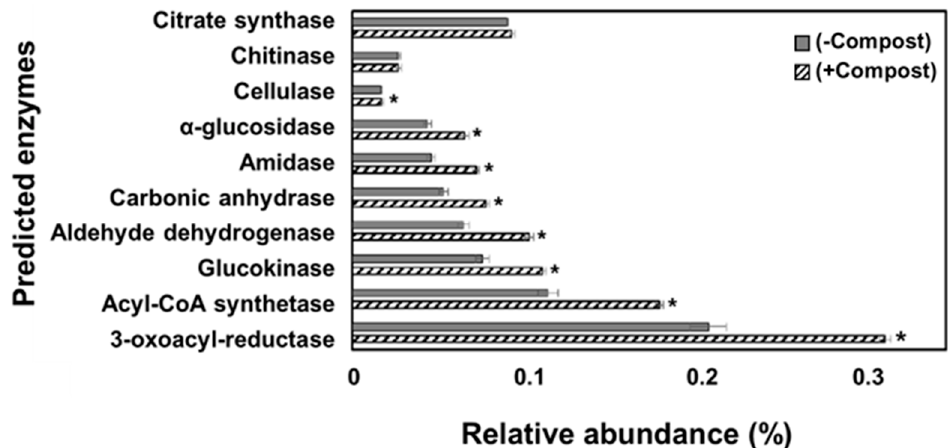
Figure 4. The abundance of genes encoding enzymes in the two soil samples related to plant growth promotion, development, and fatty acid biosynthesis predicted by the PICRUSt. Error bars indicate standard errors; the relative abundance of enzyme-encoding genes with significantly differed between treatments are marked by asterisk (*: p < 0.05).